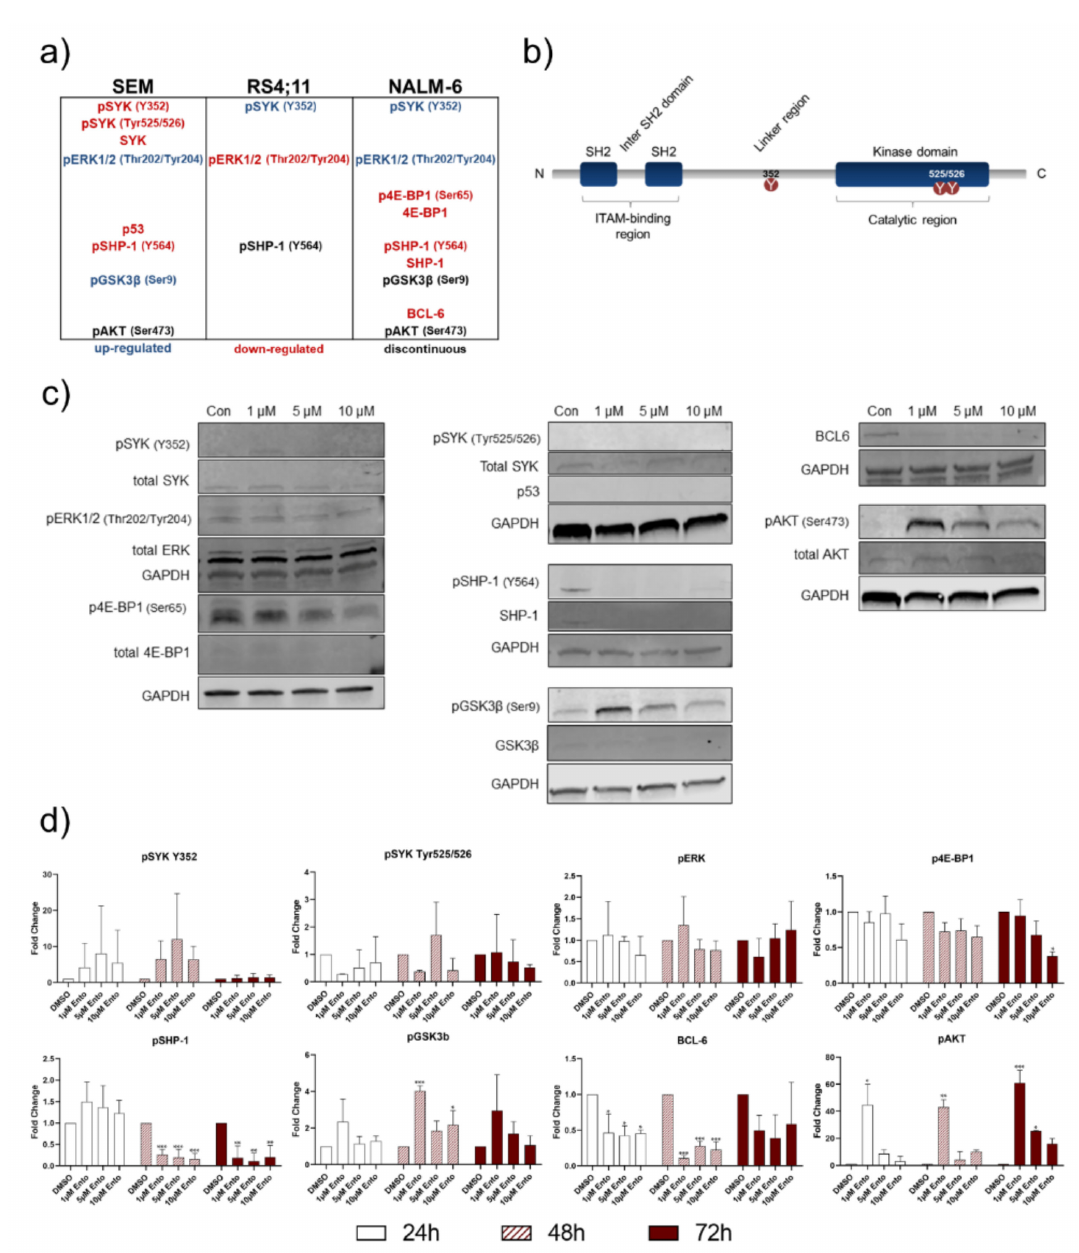
Figure 7. Entospletinib-induced distinct downstream protein modifications in pre-B-ALL NALM-6. Western Blot analyses revealed distinct changes in the SYK downstream proteins in pre-B-ALL NALM-6. ( a ) Condensed conclusion of protein modifications in all tested B-ALL cell lines. ( b ) Schematic illustration of the SYK protein structure, showing the amino acids used to examine the phosphorylation status. ( c ) Representative Western blot images of NALM-6 cells after 72 h entospletinib exposure. ( d ) Western blot quantification of key proteins after 24 h, 48 h and 72 h exposure ( ≥ 3 independent Western blots). Data are presented as the mean ± SD. Statistical significance was calculated by one-way ANOVA followed by Dunnett’s test as a post-hoc analysis and displayed as * p < 0.033, ** p < 0.002, *** p < 0.001 versus the control group ( n ≥